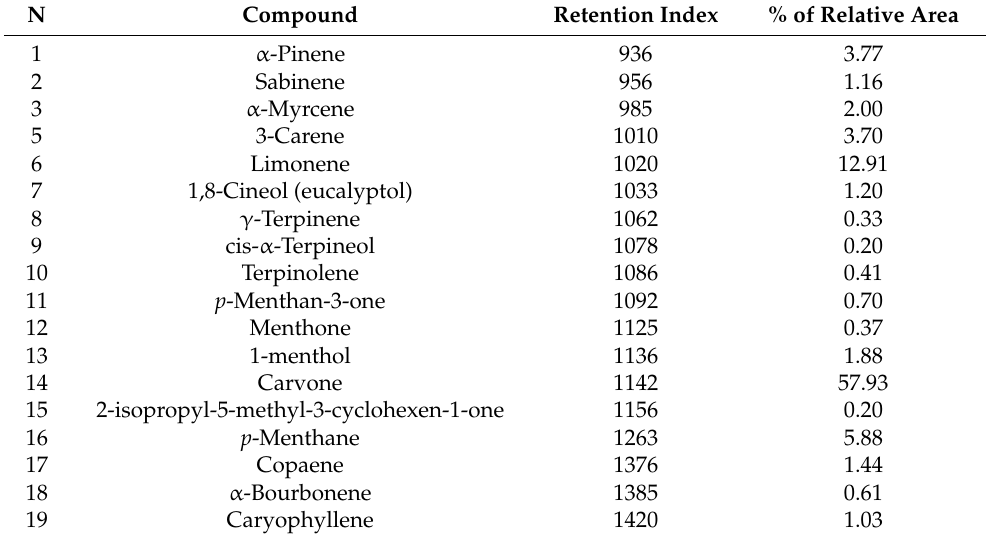
Table 1. Components in the essential oil of M. spicata .